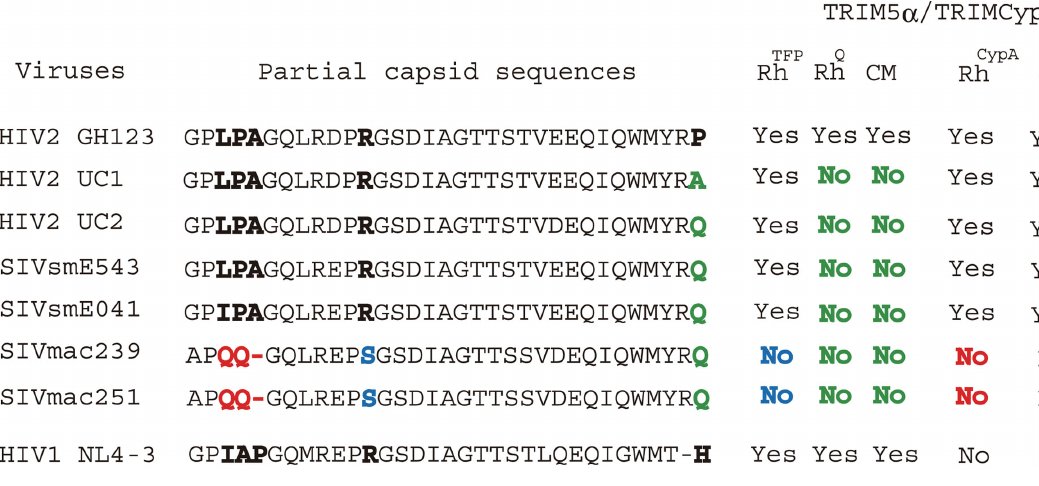
FIGURE 4 | HIV-2/SIV capsid sequence variations and restriction patterns of rhesus (Rh) and cynomolgus monkey (CM)TRIM5 α /TRIMCyp alleles. “Yes” denotes restriction. “Weak” denotes weak restriction. “No” denotes no restriction. “N. D.” denotes no result has yet been published.The unique QQ sequence at the 89th–90th positions of SIVmac, which is critical for escape from RhTRIMCyp, Rh CypA (Kirmaier et al., 2010), is shown in red. Arginine 97 at the base of the loop between helices 4 and 5, which is